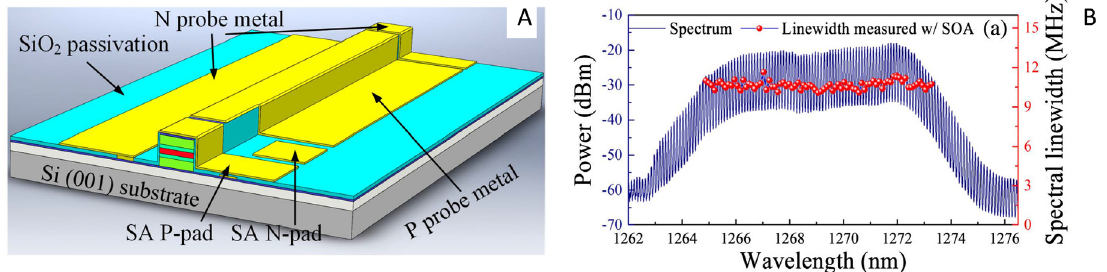
Figure 6: (A) Schematic of the 20 GHz quantum dot passively mode-locked laser on silicon (not to scale). (B) Optical spectrum and optical linewidth of individual comb lines. Reprinted with the permission from Ref. [42], Copyright 2019, Optical Society of